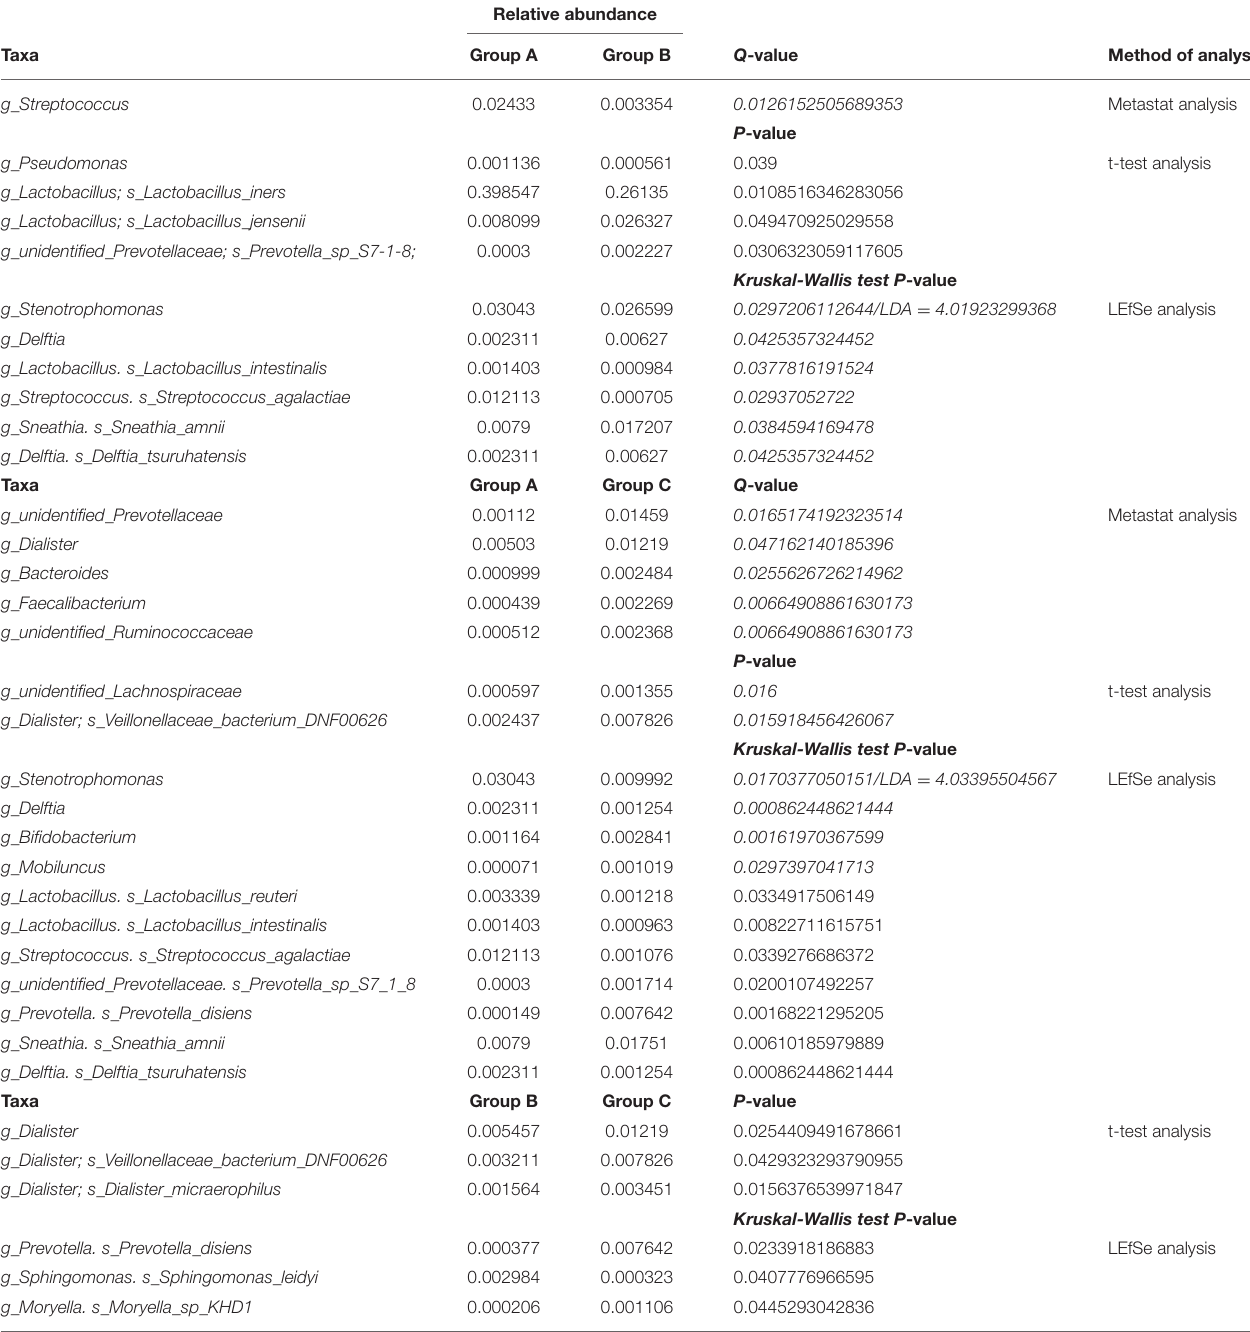
TABLE 2 | The statistically different genera and species within three